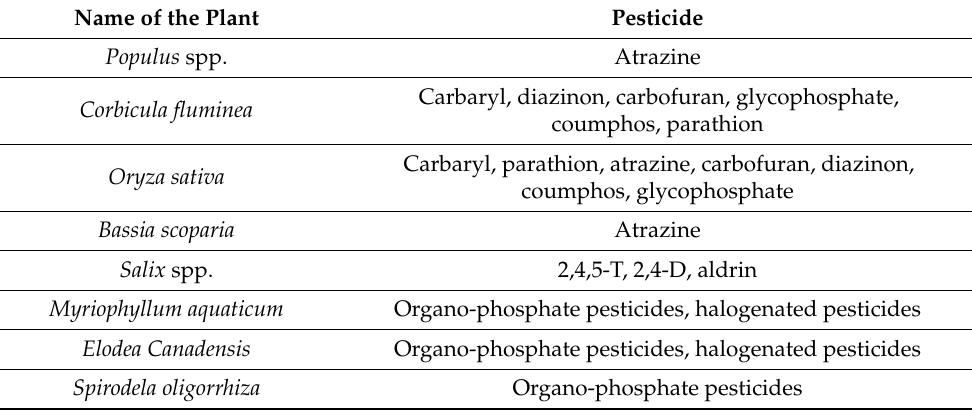
Table 8. Examples of plants involved in the remediation of